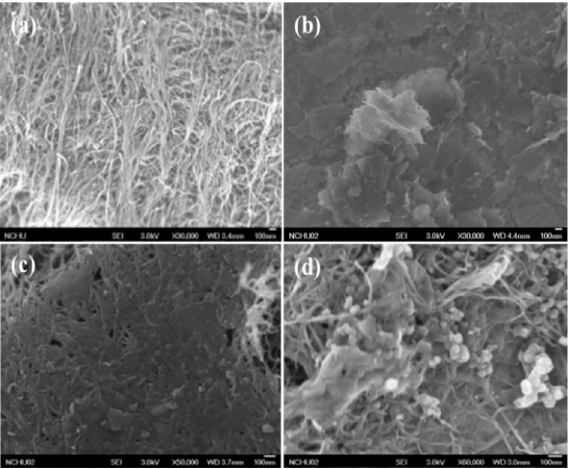
Figure 6. SEM images of ( a ) f -CNT, ( b ) V 2 O 5 gel, ( c ) V 2 O 5 / f -CNT, and ( d ) V 2 O 5 / f -CNT/PPy.